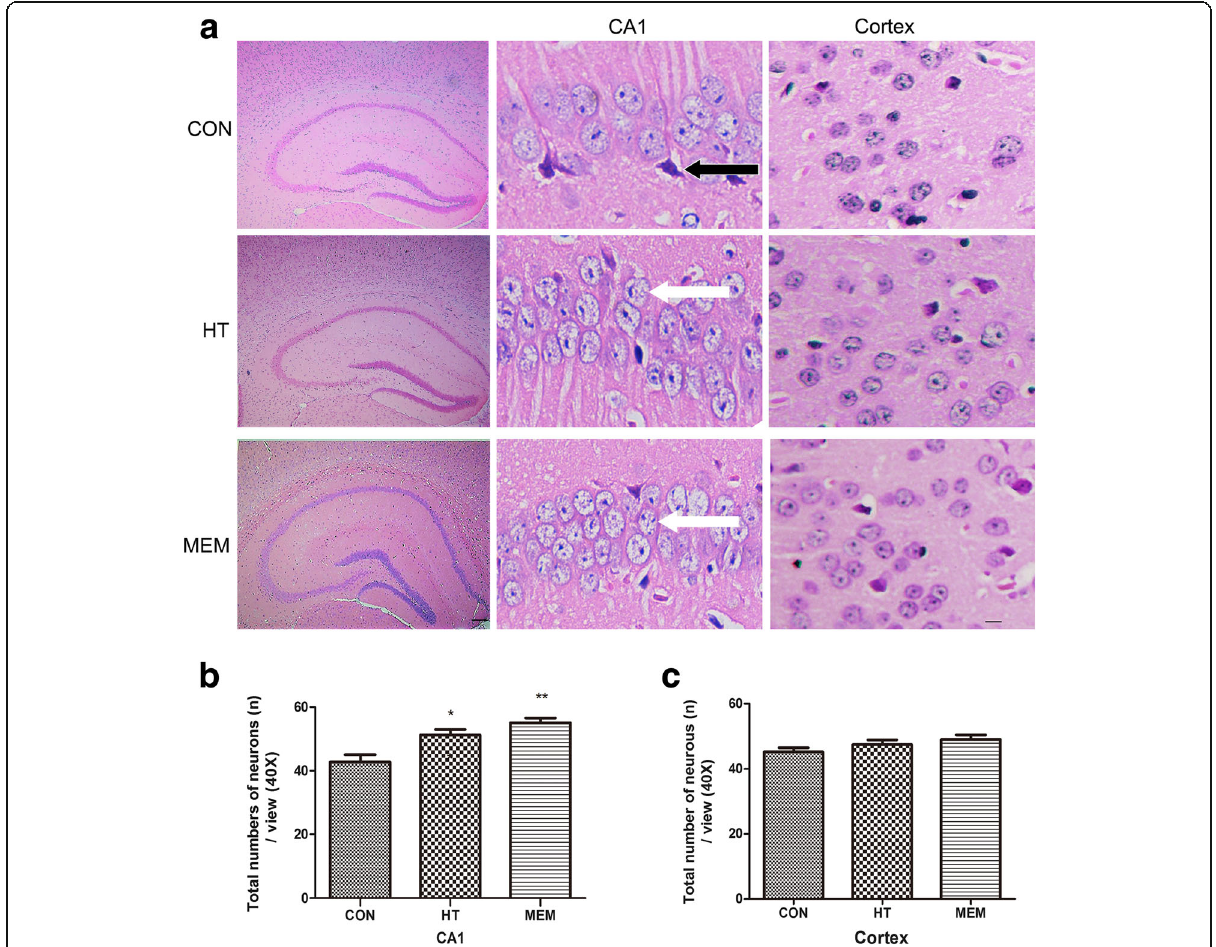
Fig. 3 Effect of HT on the histopathological changes in the hippocampus and cortex of APP/PS1 Transgenic Mice. a HE-stained images in the hippocampal CA1 and cortex of APP/PS1, HT and MEM groups. Scale bar = 200 μ m. Injured neurons in APP/PS1 mice are darkly stained and exhibited shrunken and triangulated neuronal body (black arrows). Cells are arranged indisorder with a slightly changed cell polarity, neuron loss can also be seen. By contrast, treatment with HT and MEM significantly inhibited the histopathological damage (white arrows). b The hippocampal CA1 in the HT and MEM mice contained significantly more total neurons than did that in the APP/PS1 mice. c The total numbers of neurons in cortex did not significantly differ among the three groups. Data are presented as the mean±SD. * P <0.05, ** P <0.01 versus control group. Scale bar=20 μ m, n =6 per